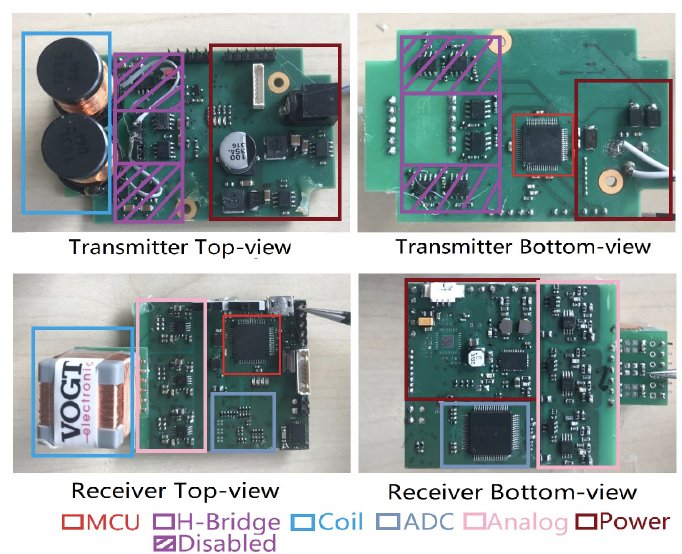
Figure 6. Minimization potential of the prototype Printed circuit board (PCB), where firstly, a plenty of free space exists, especially on the transmitter board; secondly, there is significant redundancy in terms of modules on both transmitter and receiver boards, for example, the micro-controller module and the power module.